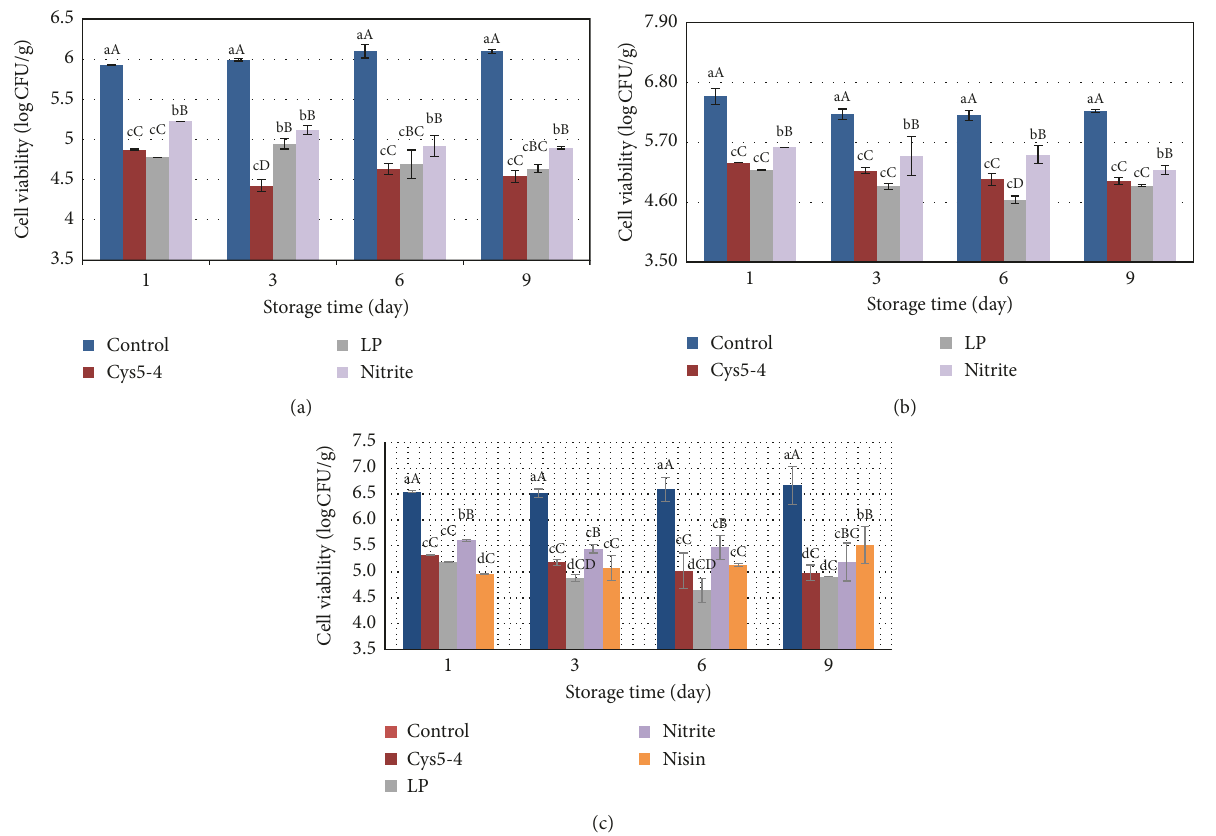
Figure 1: Average counts of microbial population in meat samples after treatment with (a) cell cultures; (b) cell-free supernatant; and (c) partial precipitated peptides, nisin and nitrite. Values with different letters are significantly different p < 0 . 05. Small letters show the difference between total contaminant-storage time and control (LSD with Bonferroni correction); capital letters indicate the differences in the cell counts at different storage time (Duncan’s test). Control: total viable counts detected in untreated meat; Cys5-4: L. plantarum UTNCys5-4; LP: L. plantarum ATCC